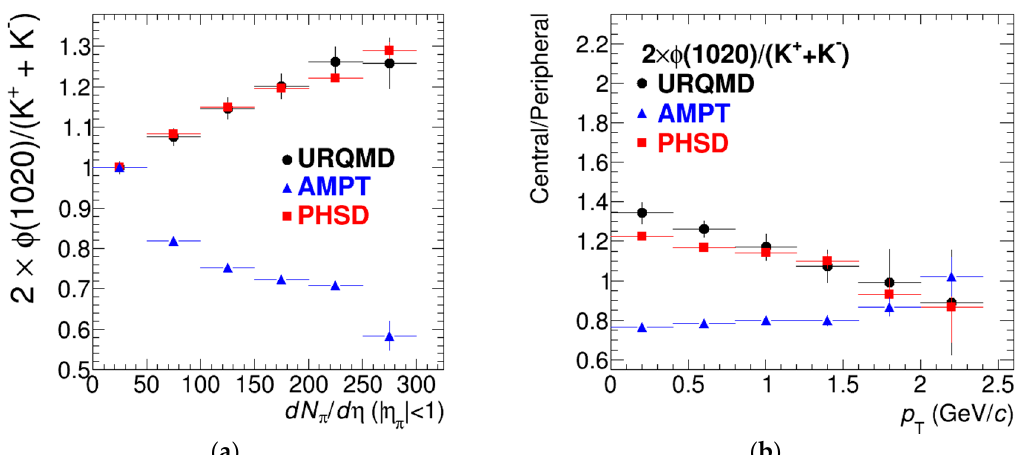
Figure 7. Ratios φ (1020)/K predicted by UrQMD [11], PHSD [12] and AMPT [13] event generators in Au + Au collisions at √ s NN = 11 GeV. The φ (1020)/K ratios normalized to unity in most peripheral collisions are shown as a function of the final state charged-particle multiplicity ( a ) and the ( φ (1020)/K) central /( φ (1020)/K) peripheral double ratio is shown as a function of the transverse particle momentum ( b